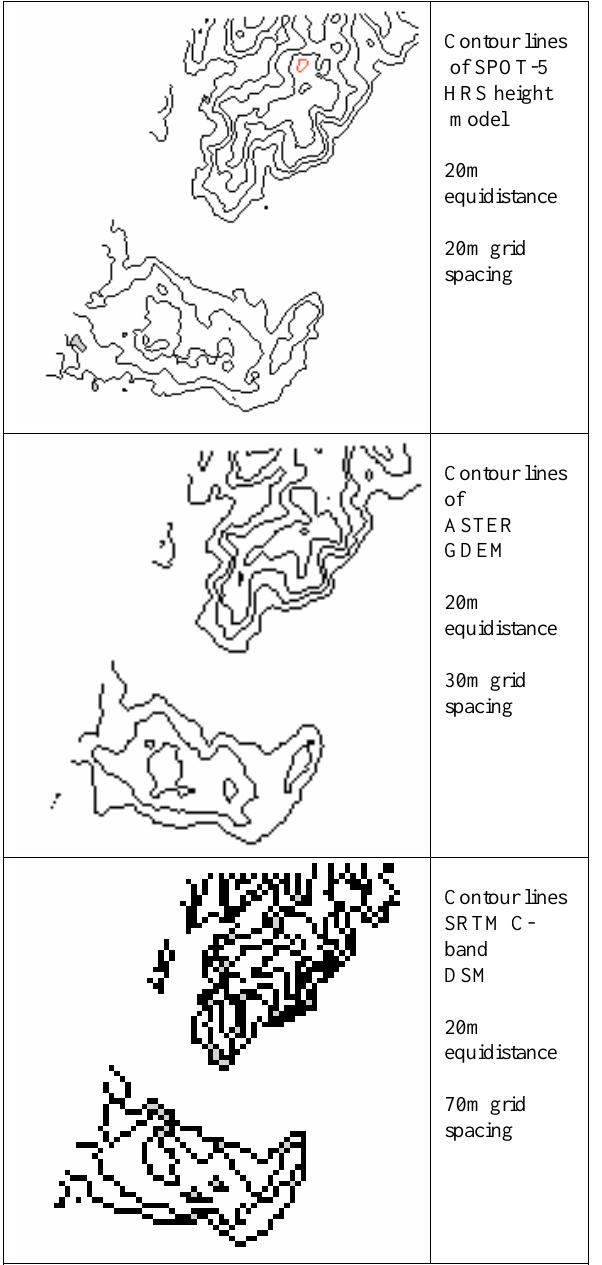
Figure 9. contour lines of the height models demonstrating the morphologic quality (Istanbul)